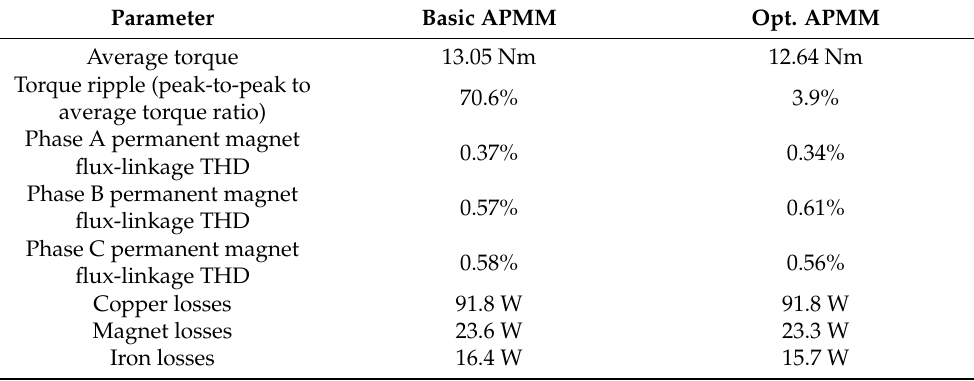
Figure 15. Waveforms and harmonic spectra of the permanent magnet flux-linkage for the three phases of the basic and optimized APMM. Table 8. Comparison between the basic and optimized APMM with 20 stator